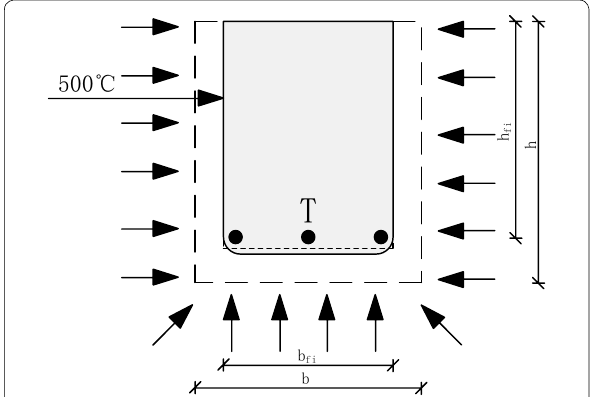
Fig. 24 Fire exposure on three sides with the tension zone exposed